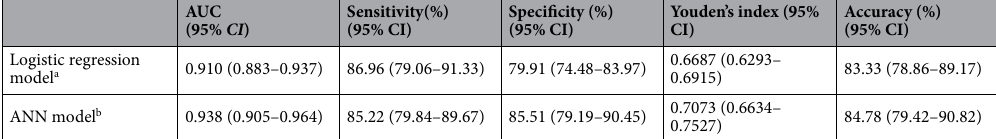
Table 5. The evaluation indicators of different predictive models in development set. AUC area under the curve, ANN artificial neural network. a When compared with Logistic regression model, there was statistical difference in AUC ( P < 0.05). b When compared with ANN model, there was statistical difference in AUC ( P < 0.05).